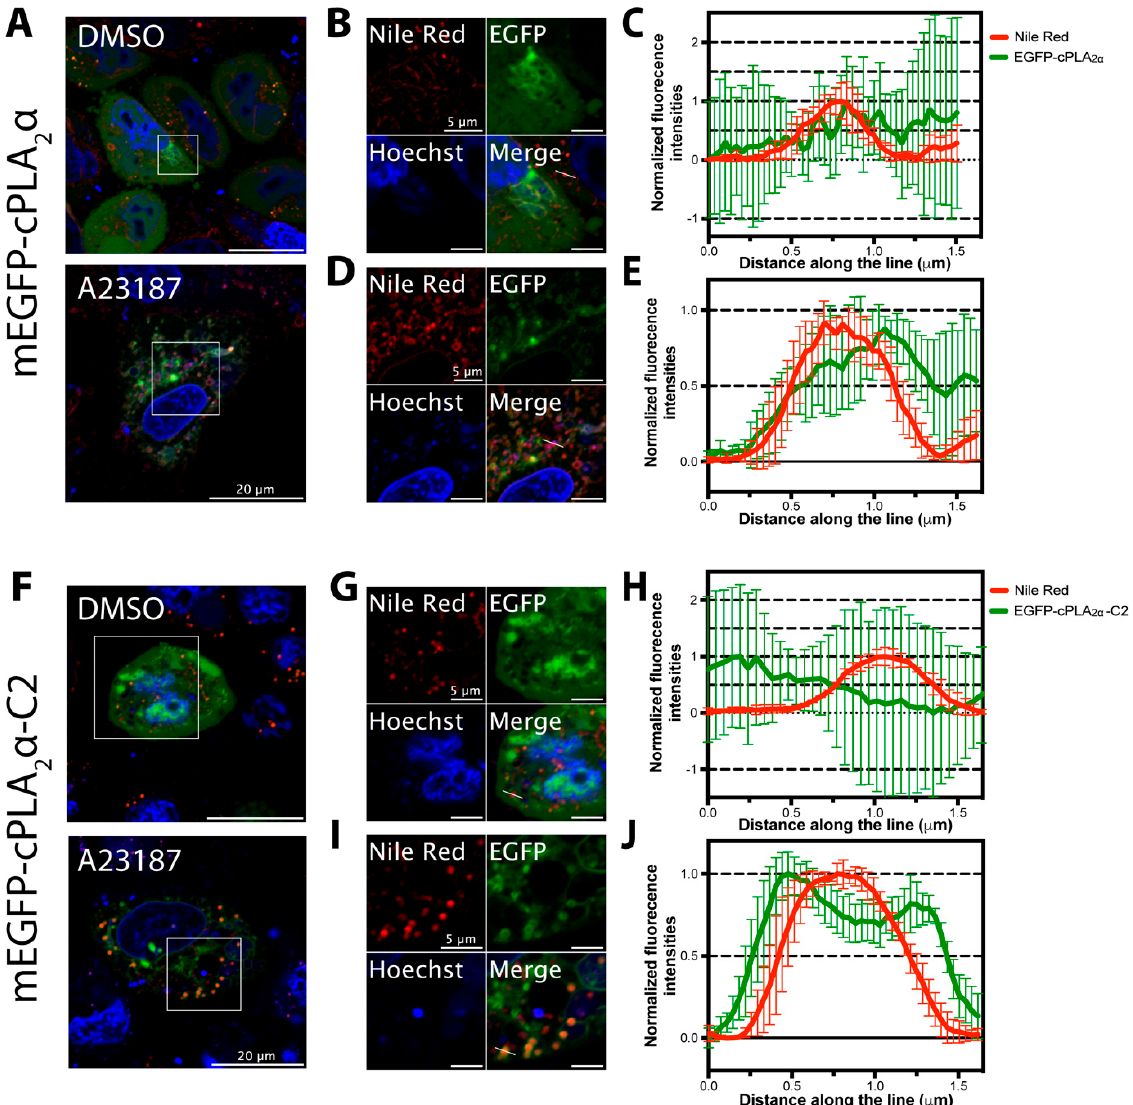
Figure 8. The cPLA 2 α -C2 domain was enriched on lipid droplet membranes following an increase in cytosolic Ca 2 + . HeLa cells were transfected with either EGFP-cPLA 2 α ( A , B , D ) or EGFP-cPLA 2 α -C2 ( F , G , I ) for 15 h, treated with 5 µ M Hoechst (DNA staining) and 10 µ g / mL Nile Red (lipid droplets staining) for 20 min, and treated with 10 µ M A23187 or equivalent volume of DMSO for 30 min at 37 ◦ C then imaged with confocal microscopy. B and D ) are zoomed insets of EGFP-cPLA 2 α in A , cells treated with DMSO and A23187, respectively. C and E ) are representative plot profiles of fluorescence intensity distributions of both Nile red and EGFP along the white line indicated in B and D , respectively. G and I are zoomed insets of EGFP-cPLA 2 α -C2 in F , treated with DMSO and A23187, respectively. H and J ) are representative plot profiles of fluorescence intensity distributions of both Nile red and EGFP along the white line indicated in G and I , respectively. Scale bars: 20 µ m in A and F , 5 µ m in B , D , G , and I .